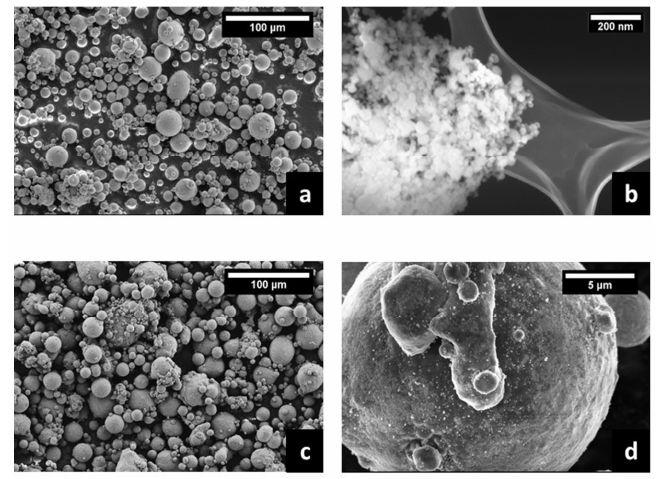
Figure 1. FESEM (field emission scanning electron microscope) images of: ( a ) the AlSi10Mg alloy; ( b ) the nanoMgAl 2 O 4 spinel; ( c , d ) and the mixed particles at different magnifications.